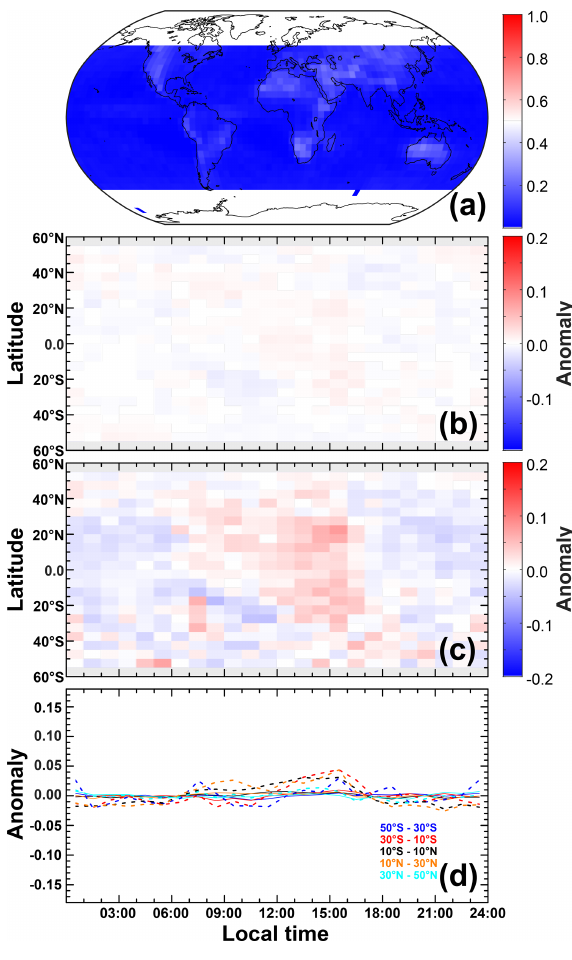
Figure 8. Occurrence rate of isolated mid-level clouds in CATS ob- servations between March 2015 and October 2017 as (a) global dis- tribution, (b) and (c) anomaly in the diurnal variation of the zonal distribution over all surfaces and land only, and (d) anomaly in the diurnal variation of the zonal average in five latitude bands: 50– 30 ◦ S (blue), 30–10 ◦ S (red), 10 ◦ S–10 ◦ N (black), 10–30 ◦ N (or- ange), and 30–50 ◦ N (light blue) over all surfaces (solid) and land only (dashed). The anomaly is calculated as the difference between hourly values and the daily mean